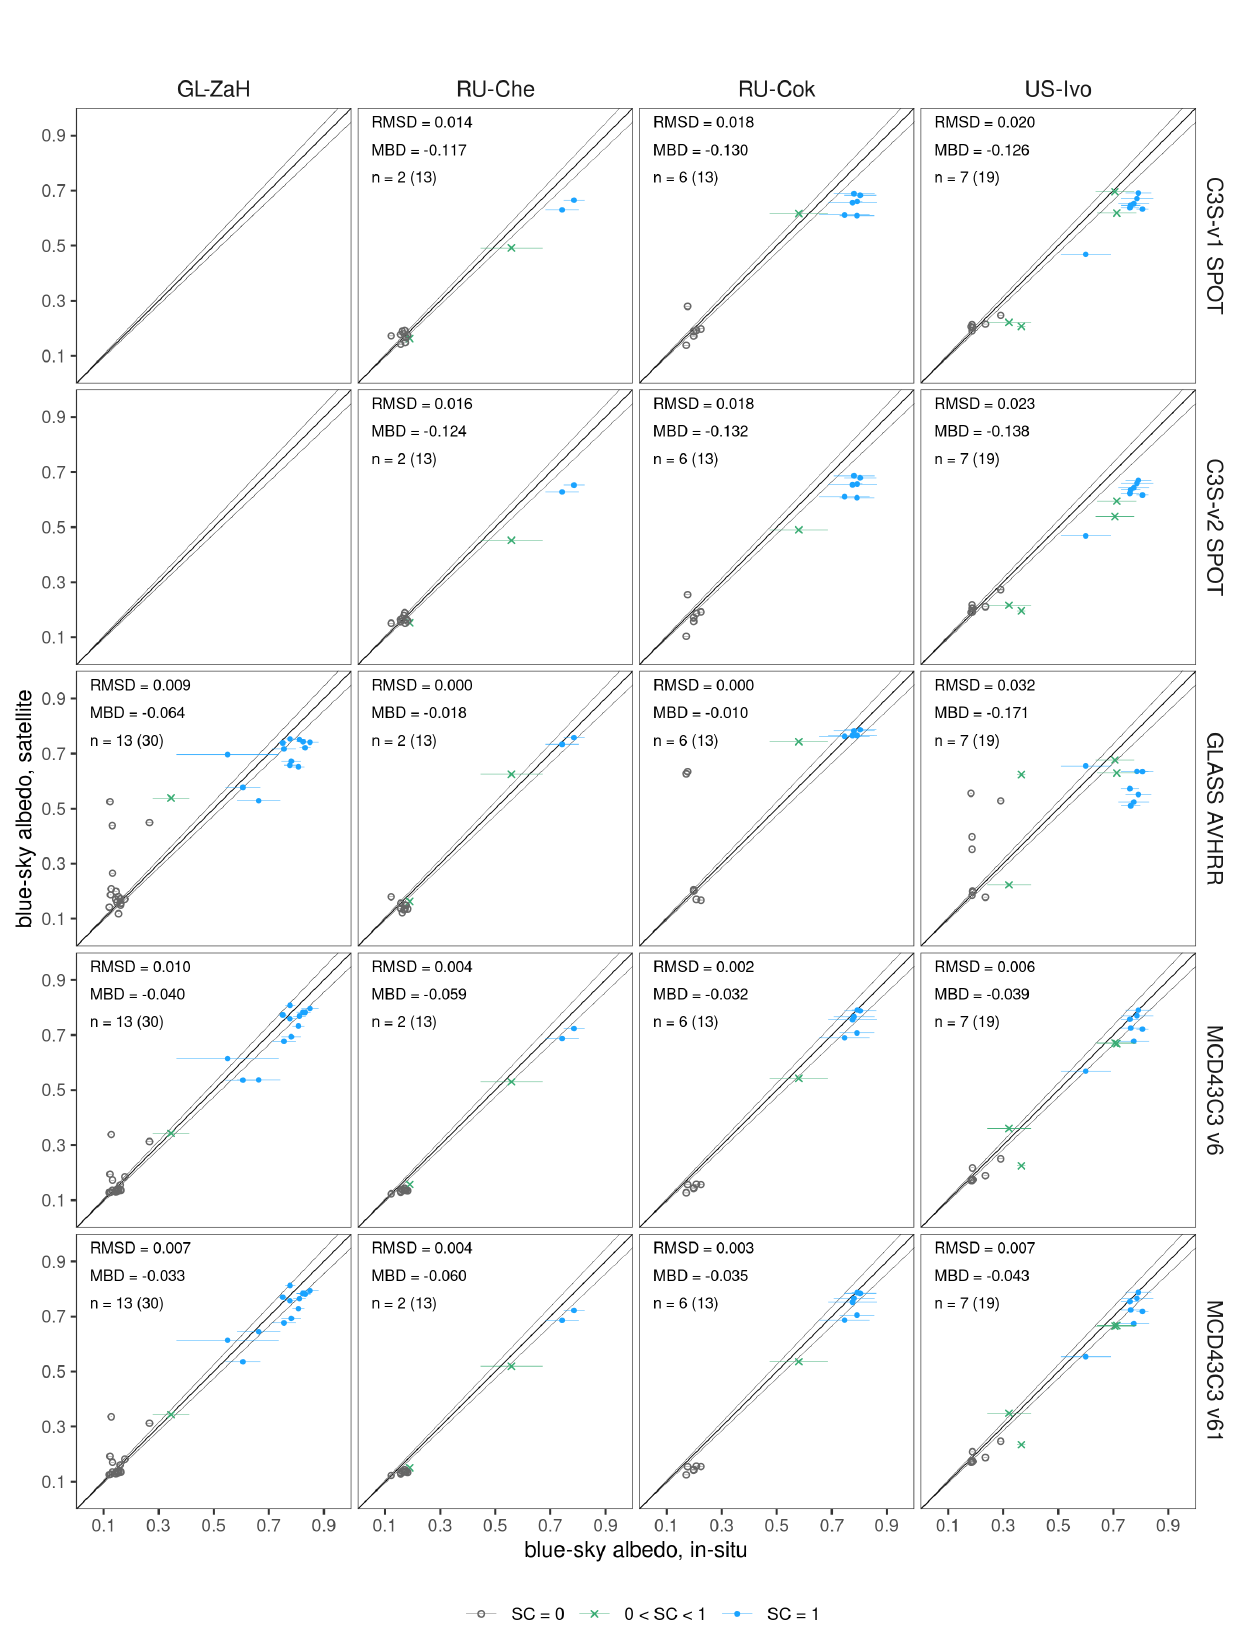
Figure 4. Same as Figure 3 but for Fluxnet